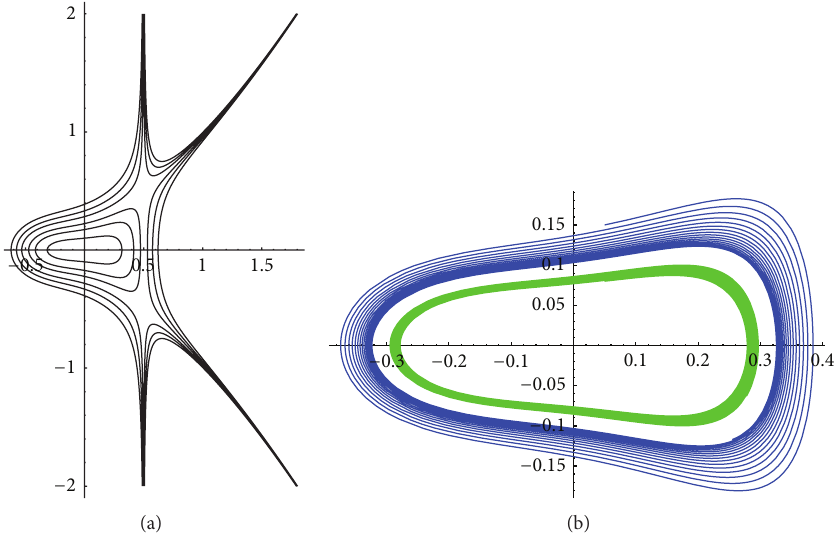
Figure 1: (a) The phase portrait of system (19) on the (𝑥,𝑦) -plane which shows that it is integrable at the origin; (b) the stable limit cycle bifurcated from the origin of system (24) with 𝛿 = 0.001 , 𝑑 1 = 1 , 𝑎 0 = 1/6 , 𝑏 0 = 1/3 + 0.001